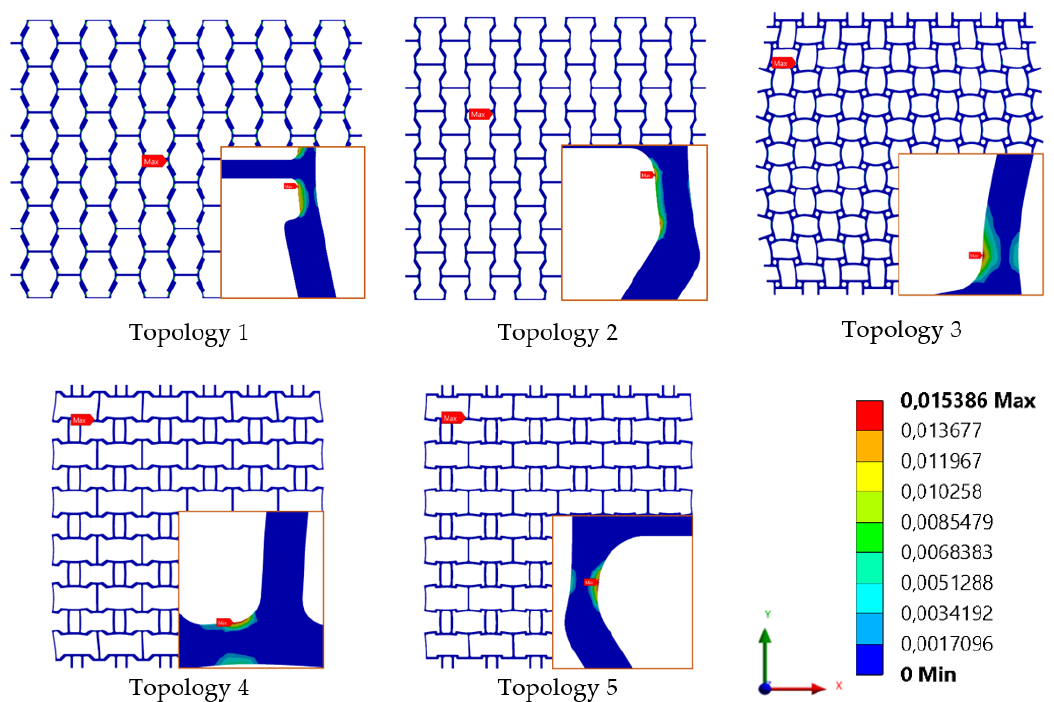
Figure 9. Location of the maximum equivalent plastic strain and its distribution.